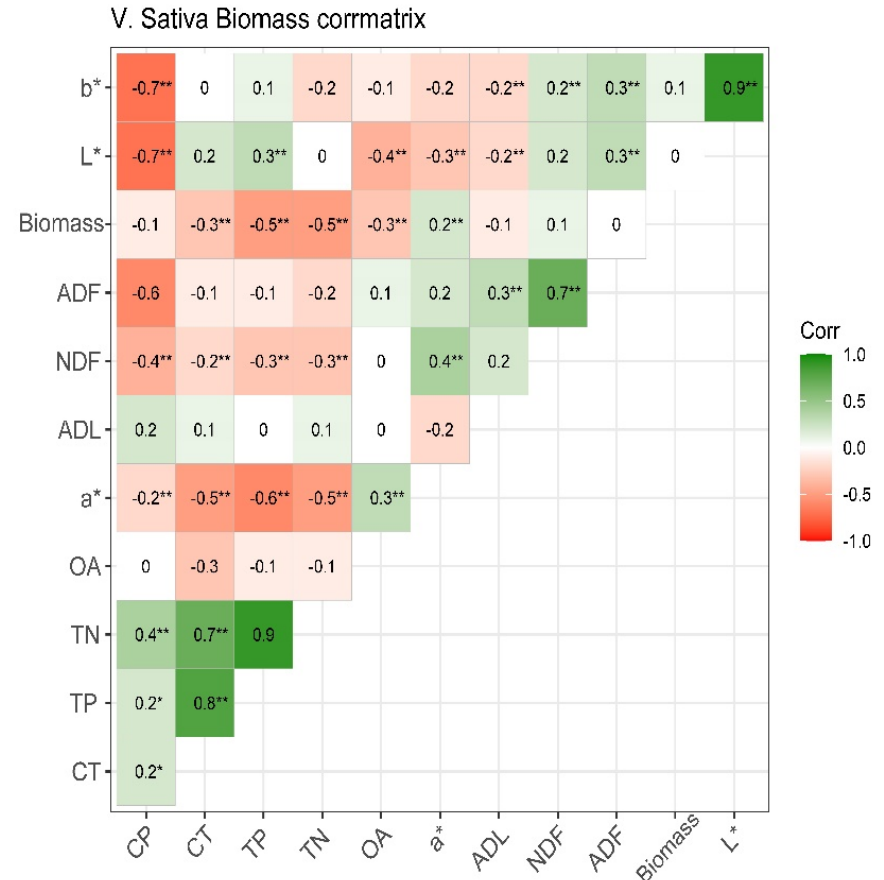
Figure 1. Pearson correlation coefficients heatmap of agronomic/colorimetric, nutritional and antinutritional traits of V. sativa biomass produced by seven genotypes across six environments. Dark green denotes high correlation (r = 1), dark red high negative correlation (r = − 1); *, ** significant at p < 0.05 and p < 0.01, respectively.